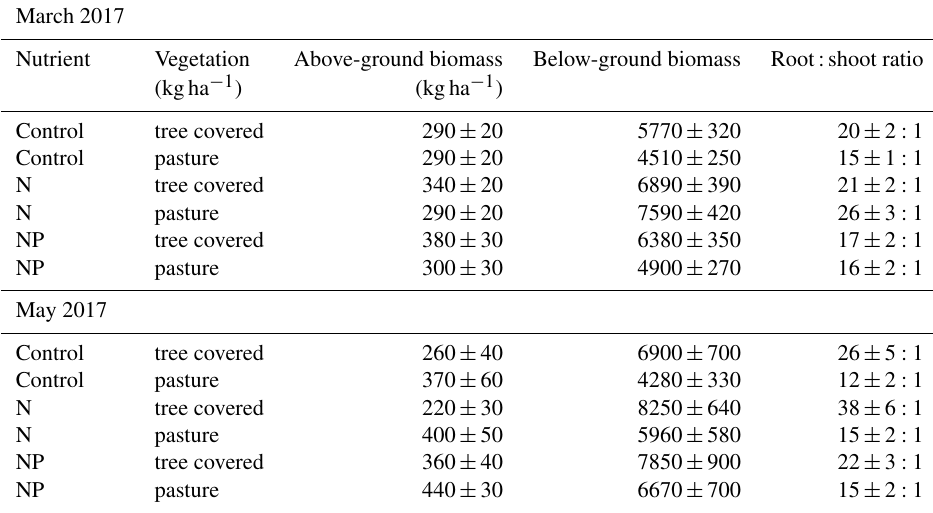
Table 2. Absolute (herbaceous layer) biomass measurements and root:shoot ratios at two points in 2017. Root:shoot ratio increased later in the growing season but tended to decrease in nutrient-added treatments, with the exception of N:pasture in March and N:tree covered in May, which exhibited an unusually high root:shoot